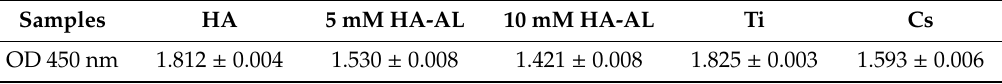
Table 2. SaOs2 cells’ proliferation on the surface of HA-AL biomaterials upon 72 h culture.